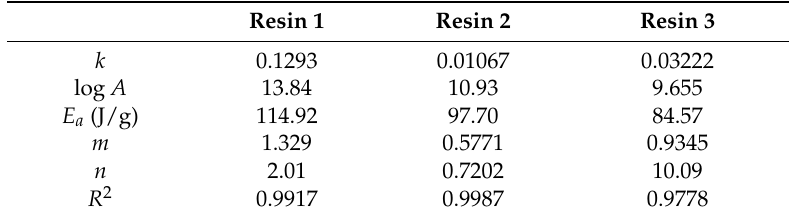
Table 3. Constants of curing reaction kinetics described in Equations (2)–(4).